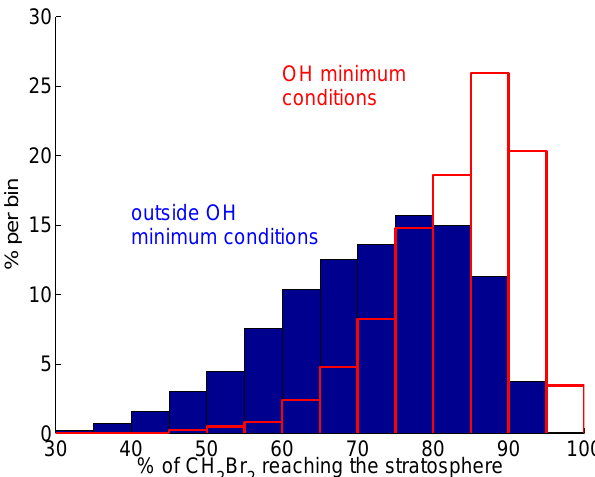
Fig. 9. Distribution of the fraction of boundary layer CH 2 Br 2 sur- viving the transport through the troposphere for “outside minimum” conditions (filled blue) and “OH minimum” conditions (outlined red).